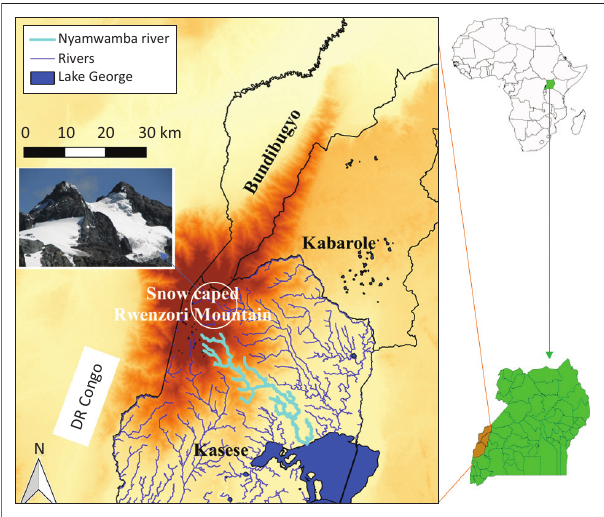
FIGURE 1: Location of Nyamwamba River in south-western Uganda (Africa).